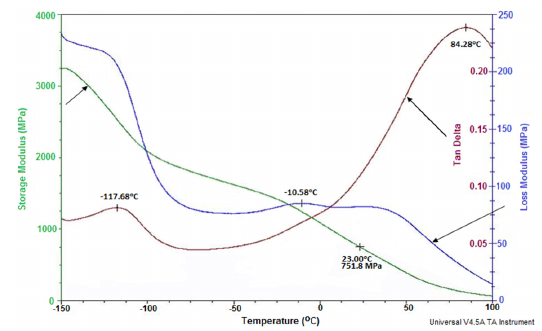
Figure 9. DMA analysis of the LH05